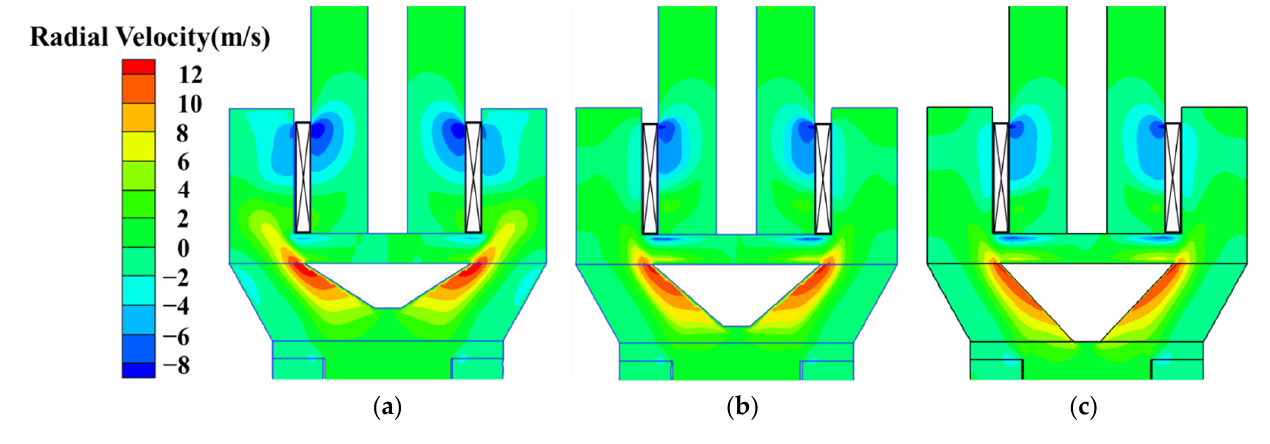
Figure 6. Effect of the guide cone height on the radial velocity: ( a ) H = 64 mm, ( b ) H = 84 mm, ( c ) H = 104 mm.